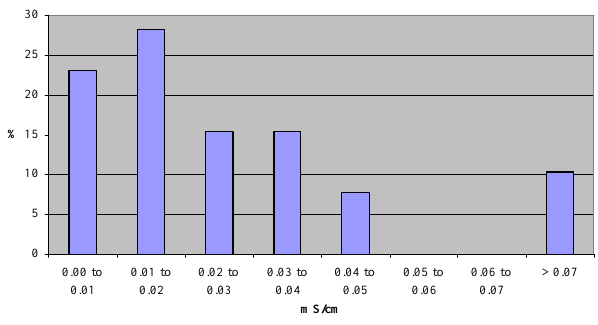
Fig. 2. Annual drift statistics of the 32 thermosalinographs SBE 21 Figure 2: annual drift statistics of the 32 thermosalinographs SBE 21 of the French of the French operational oceanography project Coriolis. Only 23% operational oceanography project Coriolis. Only 23 % of them show annual shifts less than of them show annual shifts less than 0.01mScm − 1 but 51% have annual shifts less than 0.02mScm − 1 . This shows how much drift 0.01 mS/cm but 51 % have annual shifts less than 0.02 mS/cm. This shows how much drift there can be in conductivity cells submitted to strong environmental there can be in conductivity cells submitted to strong environmental conditions.